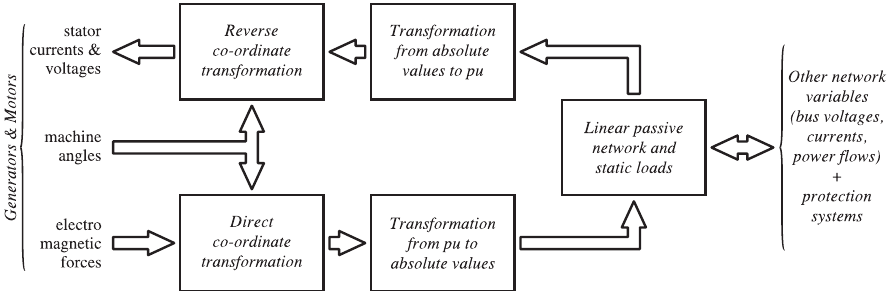
Figure 5. Functional block diagram of the interactions between machine rotors and the electric network in the